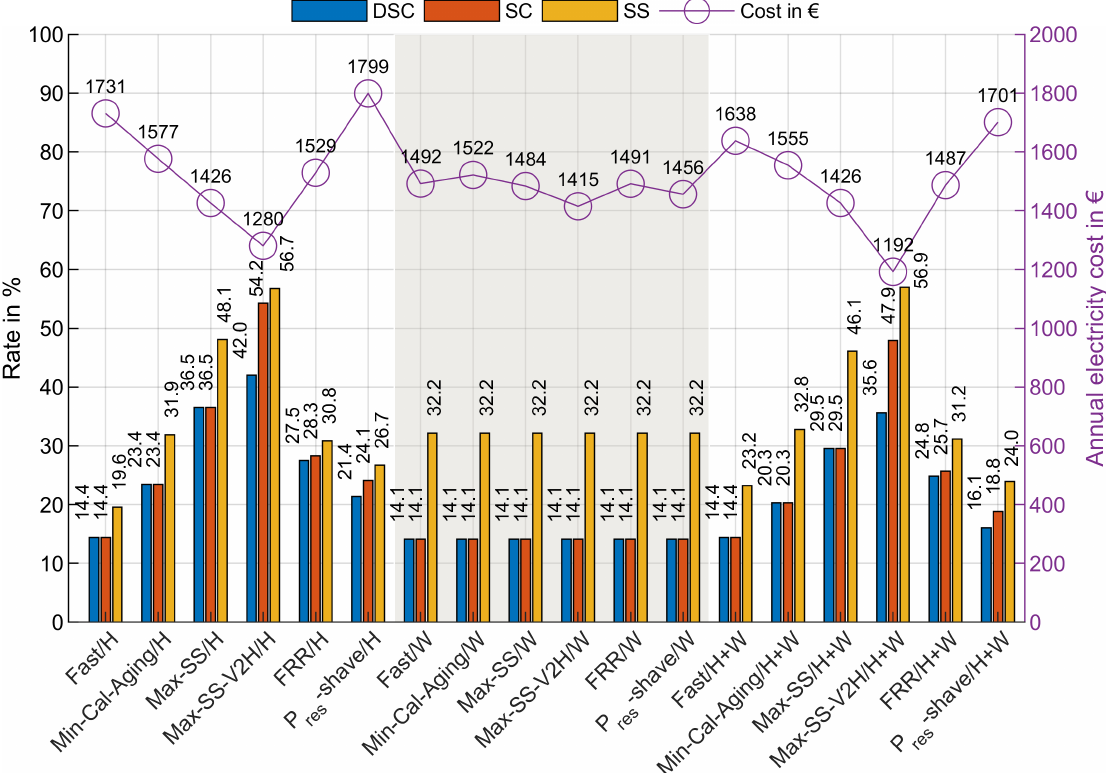
Figure 9. DSC, SC, and SS rates, and electricity cost for mobility profile Late-Worker without SoC V 2 XLimit